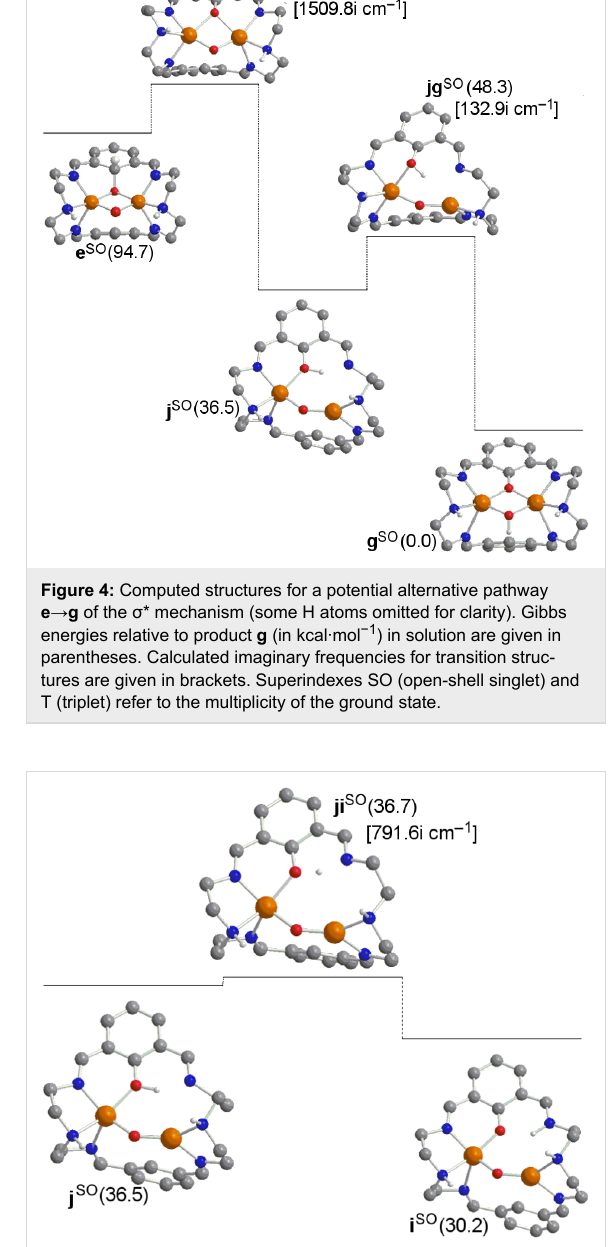
Figure 5: Computed structures for a potential alternative pathway j → i of the σ * mechanism (Gibbs energies in kcal·mol − 1 ). Superindex SO (open-shell singlet) refers to the multiplicity of the ground